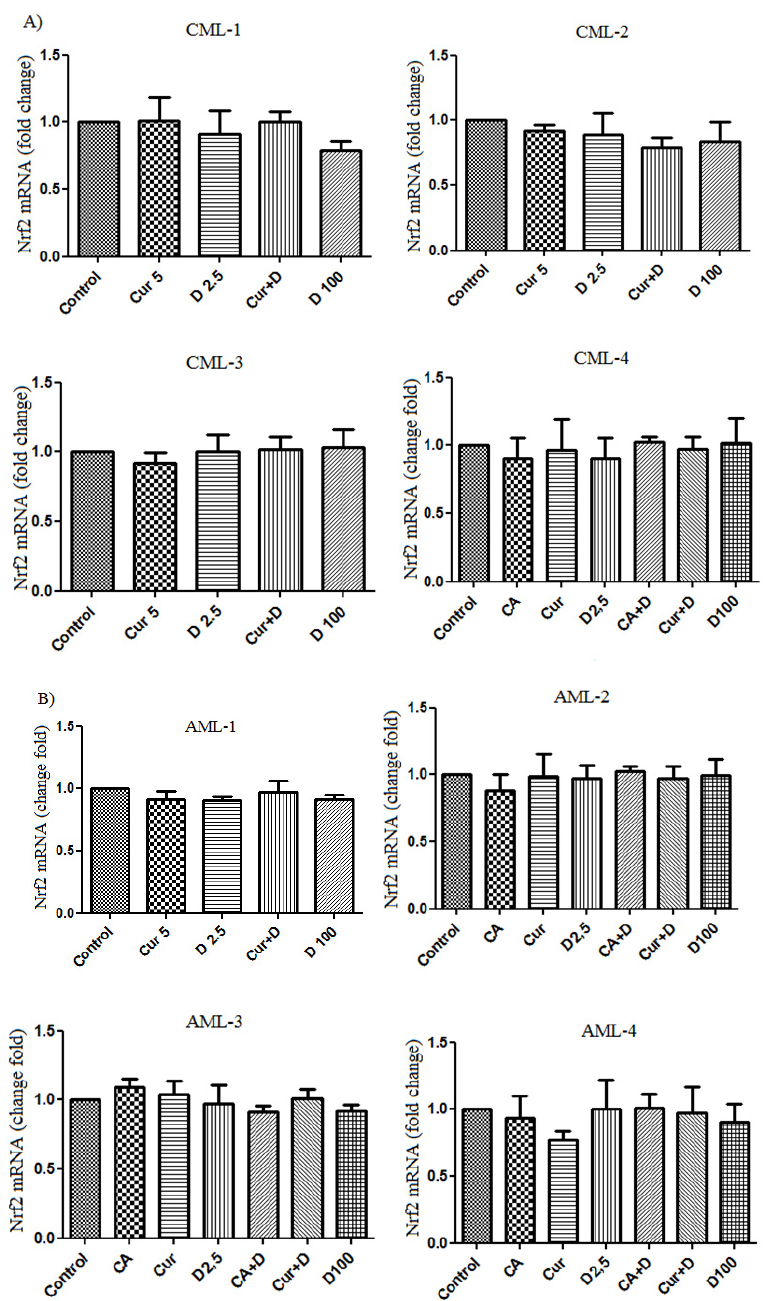
Fig. 1. Nrf2 mRNA expression level in CML (A) and AML (B) patients leukemic cells treated with CA (10 µÀM), 1,25D (2.5 nM) and 1,25D (100 nM), CUR (5 µÀM) and combinations of 1,25D (2.5 nM) with CA and CUR. Data are the means ±